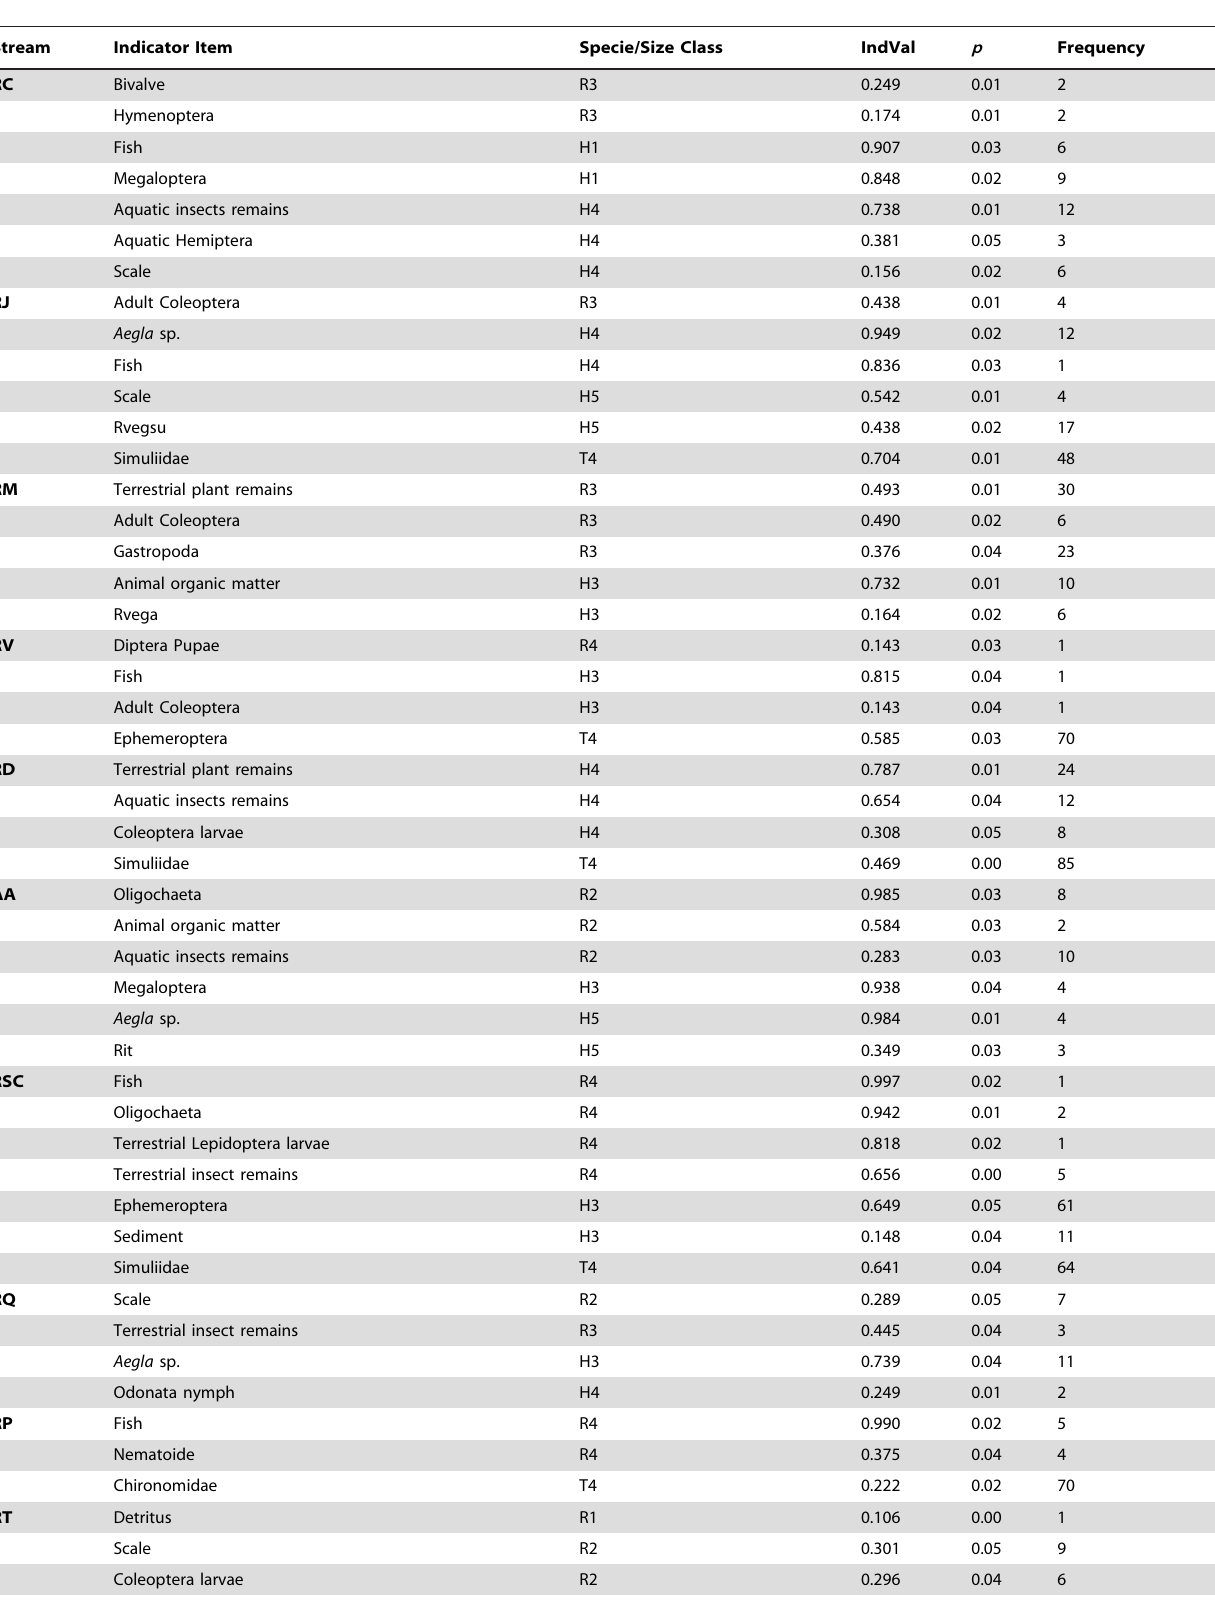
Table 4. Indicator Value (IndVal), p valeu and Frequency of food items consumed by three species analyzed, discriminated among species/size